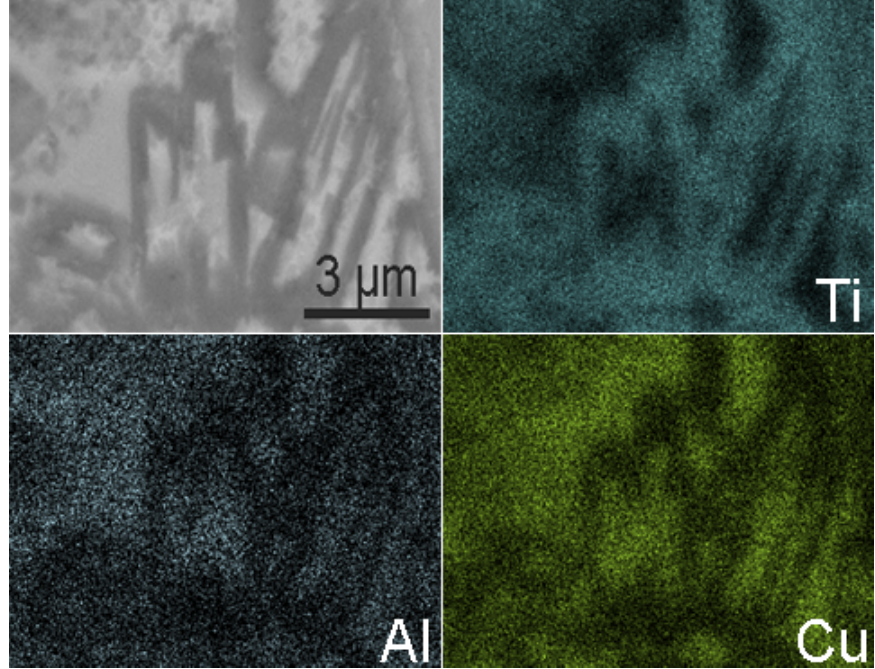
Figure 2. EDX maps of Ti, Al, and Cu for sample after sintering at 1050